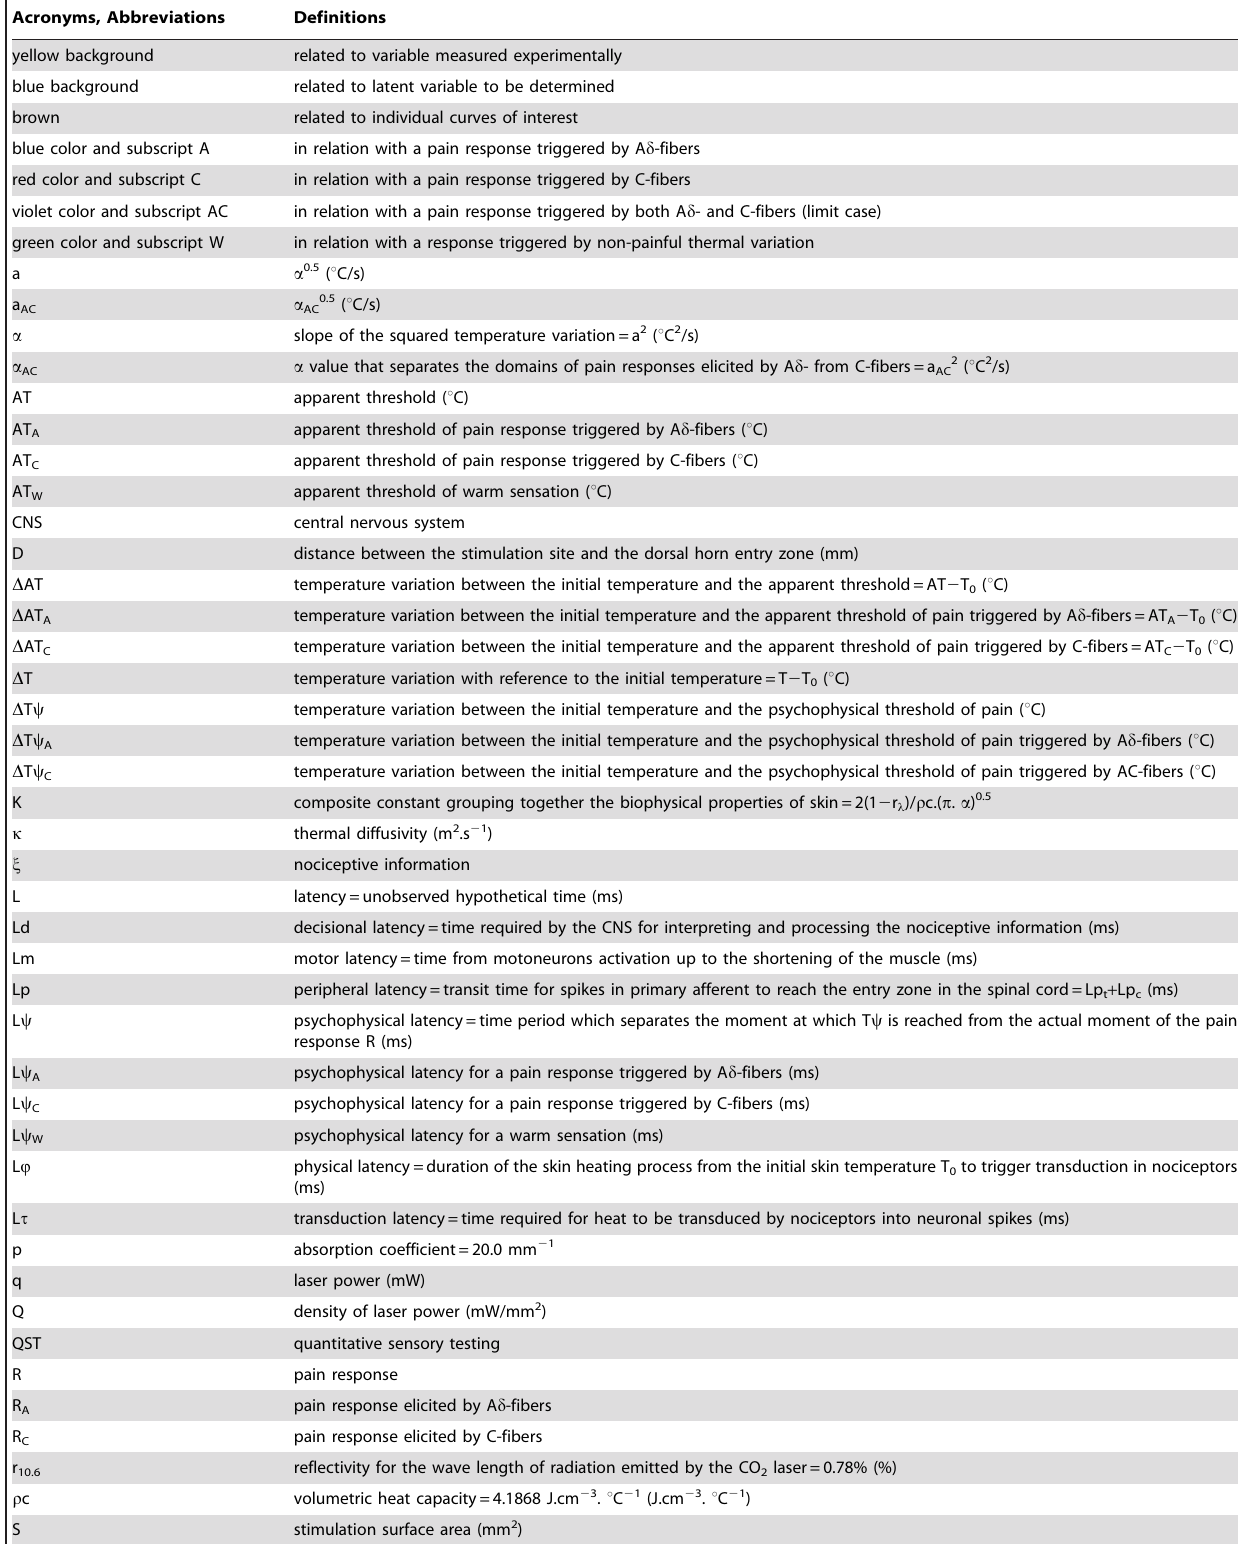
Table 1. Symbols, abbreviations and